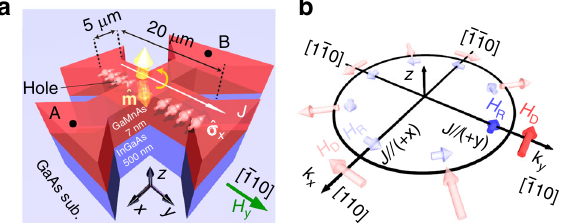
Fig. 1 Schematic illustrations of the device structure and the effective magnetic fi eld. a Schematic of SOT switching and illustration of the cross-bar device structure of the Ga 0.94 Mn 0.06 As (7nm)/In 0.3 Ga 0.7 As (500nm)/GaAs (50nm) thin fi lm grown on a GaAs (001) substrate. The channel width of the cross-bar is 5 μ m. The charge current is applied along the + y direction, and the spin component in the − x direction ( ^ σ x ) exerts a torque on the magnetic moment ( ^ m ) and reverses it. b Dresselhaus-like (red) and Rashba-like (blue) effective magnetic fi elds ( H D and H R , respectively) for hole momenta along different crystallographic directions in the tensile Ga 0.94 Mn 0.06 As thin fi lm. ( k x , k y ) is the wave vector of the holes. The dark colored arrows labeled H D and H R correspond to the effective magnetic fi elds when J